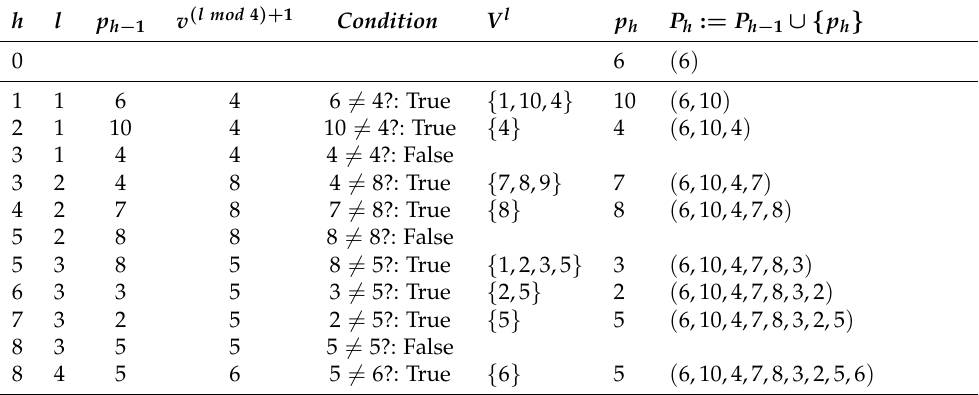
Table 1. Iterations performed by the Algorithm 1 ( GIRDING − POLYGON ) for the construction of the girding polygon P for the example instance